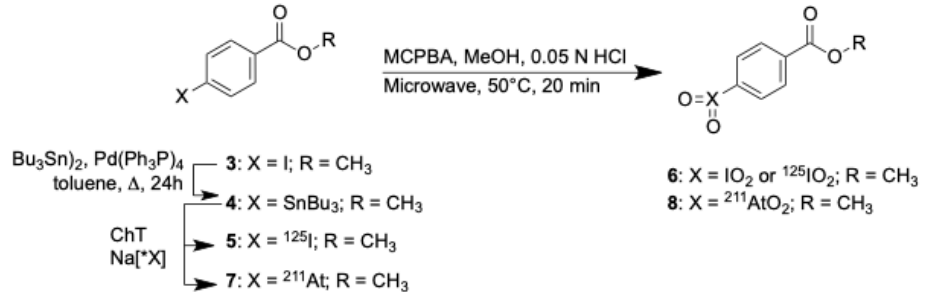
Figure 2. Reactions to prepare halobenzoic acid methyl esters and oxidized forms, including p - [ 125 I]iodoxybenzoic acid methyl ester [ 125 I] 6 and p -[ 211 At]astatoxybenzoic acid methyl ester [ 211 At] 8.